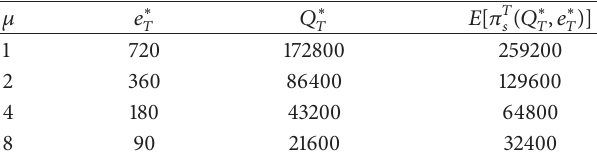
Table 6: Effect of 𝜇 on the optimal policies of the system after